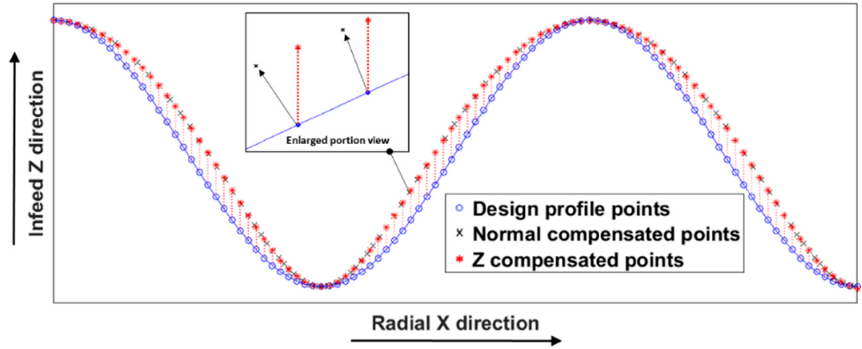
Figure 10. Comparison of two compensation methods along a radial profile .